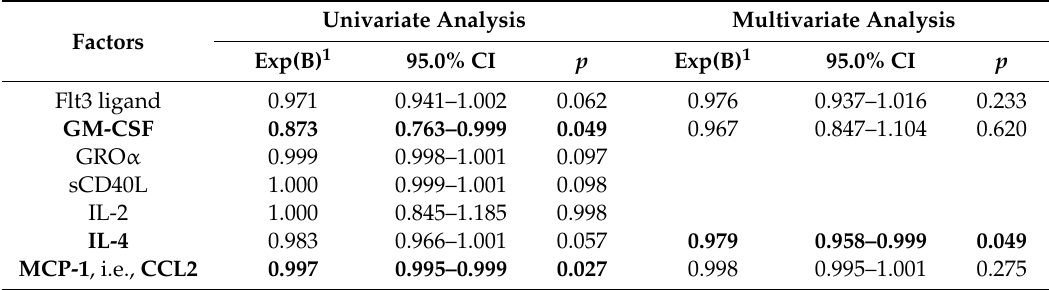
Table 6. Results of regression analysis regarding correlations of cytokines / chemokines with IHD risk in the presence of